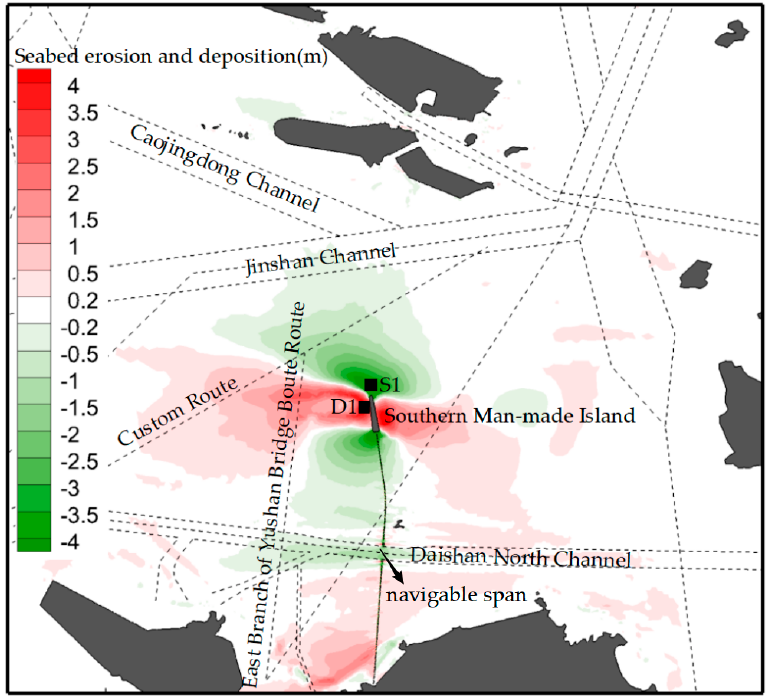
Figure 12. Simulated seabed erosion and deposition thicknesses after the construction of DSTC project. D1 and S1 are locations with maximum deposition and erosion.